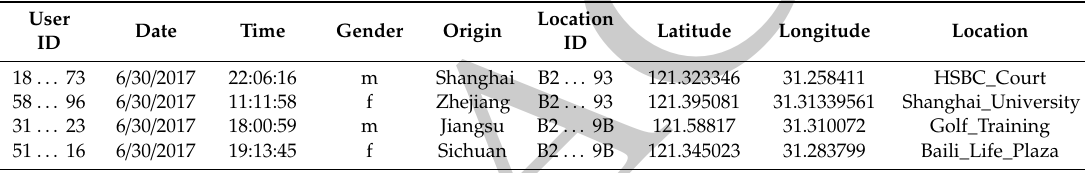
Table 1. Dataset